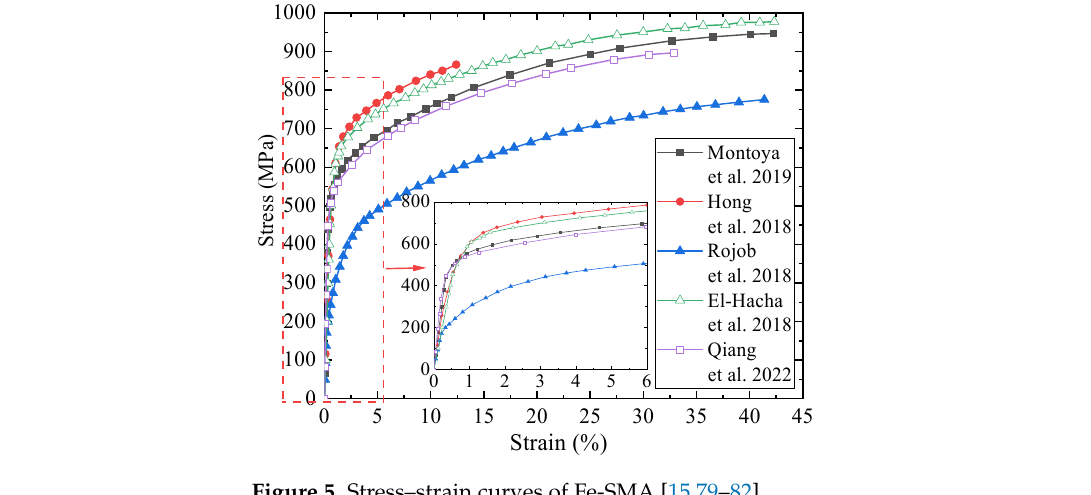
Figure 5. Stress–strain curves of Fe-SMA [15,79–82]. Table 4. Mechanical properties of Fe-SMA.